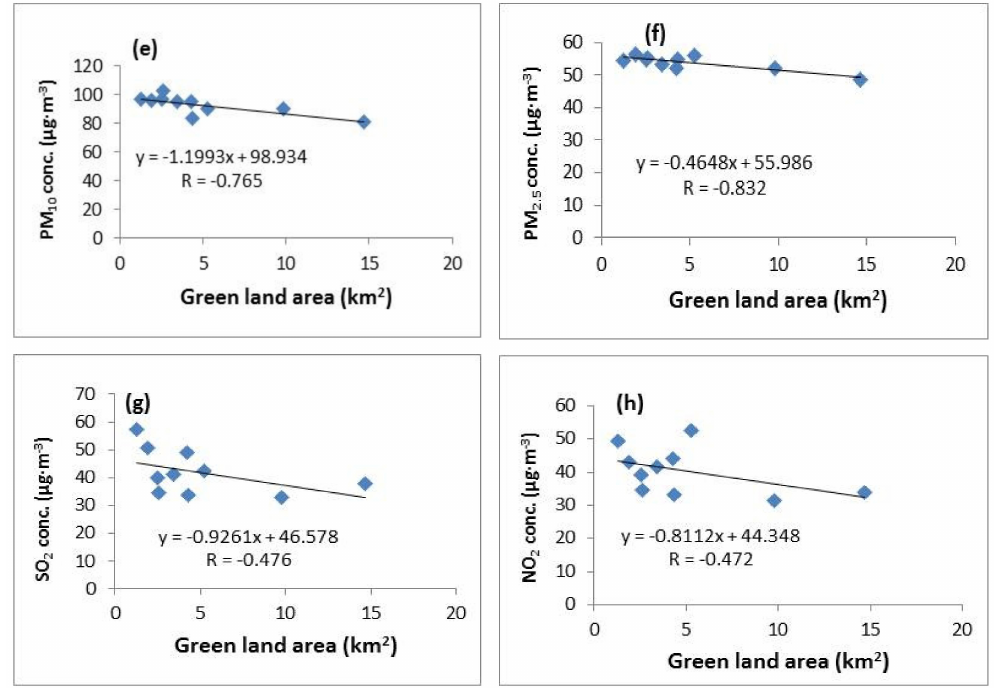
Figure 7. Scatter pots of mean annual concentrations of ( a ) PM 10 , ( b ) PM 2.5 , ( c ) SO 2 , and ( d ) NO 2 , and the amount of area covered by buildings in a 3-km-radius bu ff er, and ( e ) PM 10 , ( f ) PM 2.5 , ( g ) SO 2 , and ( h ) NO 2 , and the amount of area covered by green land (i.e., grassland or cropland), for 10 environmental monitoring stations in